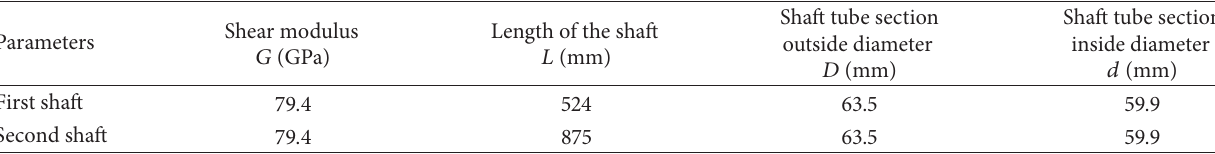
Table 1: Main parameters of the transmission shaft.